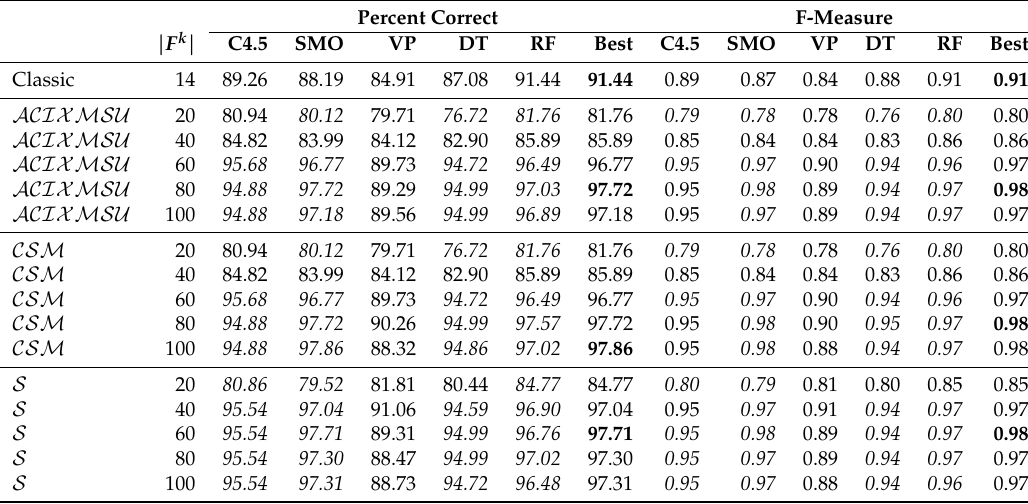
Table 7. “Use the toilet” classification